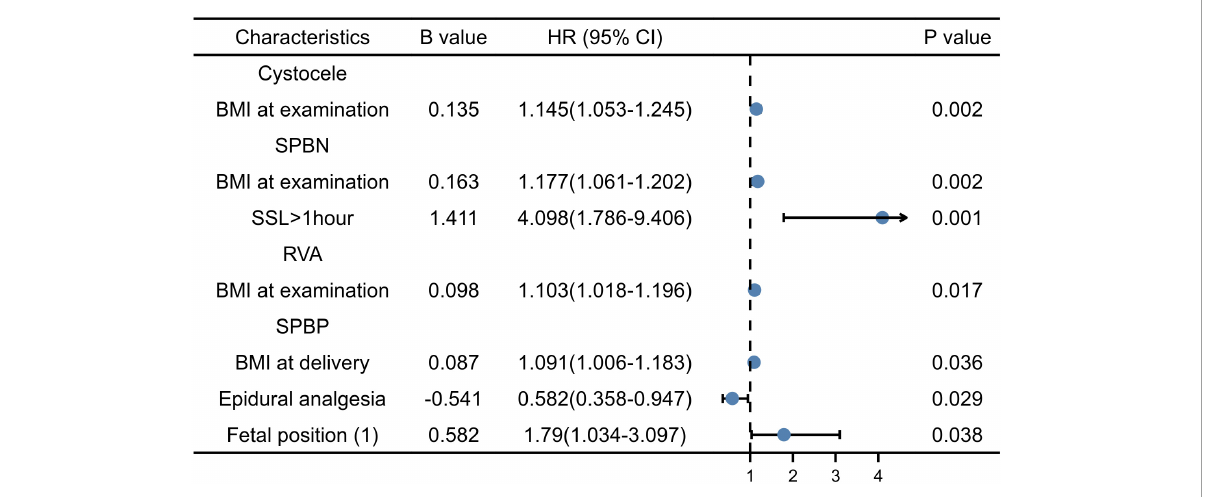
FIGURE1 Multiple factor analysis of cystocele, symphysis pubis to the bladder neck (SPBN), retrovesical angle (RVA), and symphysis pubis to the posterior wall of the bladder (SPBP).